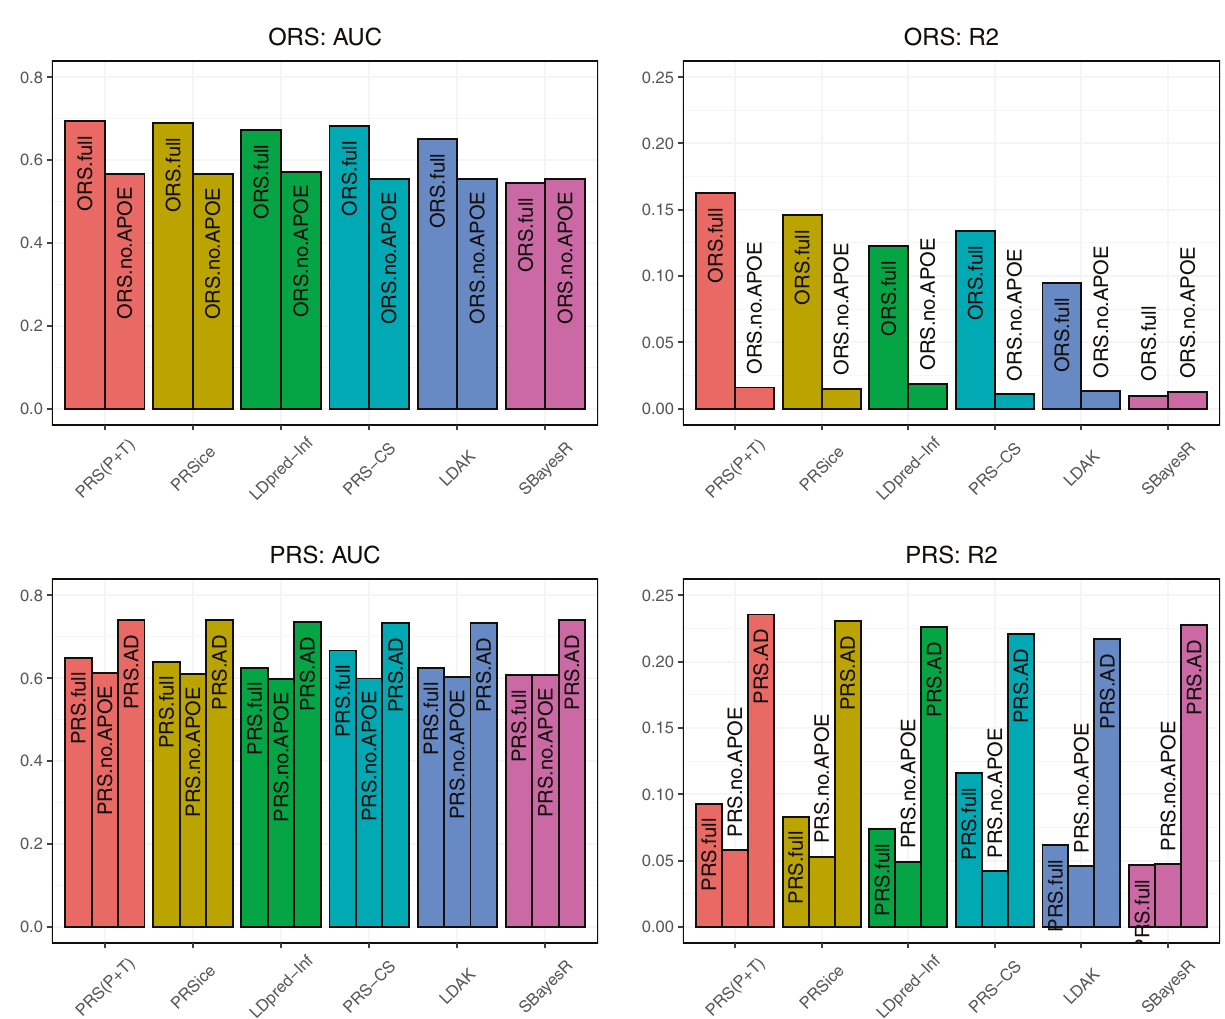
Fig. 2 Prediction accuracy across different PRS methods (PRS(C + T), PRSice, LDpred-Inf, PRS-CS, LDAK and SBayesR) for ORS.full, ORS.no.APOE, PRS.full, PRS.no.APOE and PRS.AD. Bar plot for prediction accuracy (AUC and R 2 ) across 6 PRS approaches: PRS(C + T), PRSice, LDpred-Inf, PRS-CS, LDAK and SBayesR (red, yellow, green, teal, blue, pink bars respectively). The colour of each PRS method is consistent across all plots. Upper fi gures represent ORS and lower fi gures represent PRS and PRS.AD models in the case-control dataset (271 cases and 278 controls). ORS.full includes SNPs with pT ≤ 1e-5 and PRS.full includes SNPs with pT ≤ 0.1, ORS.no.APOE and PRS.no.APOE exclude SNPs in the APOE region and PRS.AD models APOE separately and subsequently adds this to PRS.no.APOE. AUC Area Under the Curve, ORS Oligogenic risk score, PRS Polygenic risk score, AD Alzheimer ’ s Disease, SNP Single